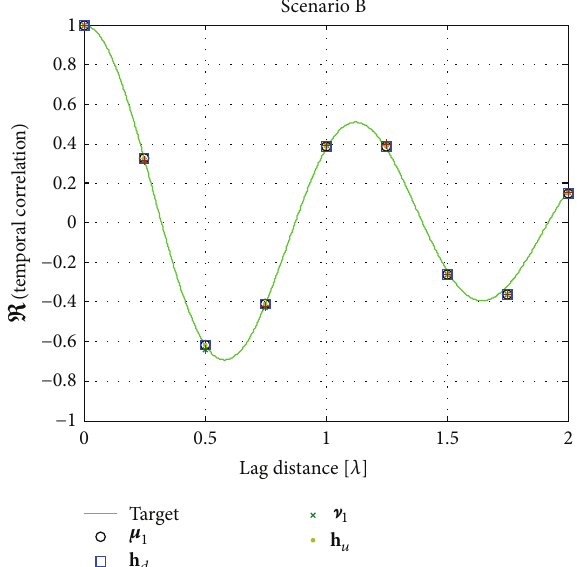
Figure 9: Temporal autocorrelations of the target channel model, unweighted fading CIR from 1st probe in the downlink 𝜇 1 , downlink fading CIR h 𝑑 , unweighted fading CIR from 1st probe in the uplink h ^ 1 , and uplink fading CIR 𝑢 for scenario B. Note that the direction oftravelis 30 ∘ inthesimulationandthefadingCIRsarefoursamples per wavelength.